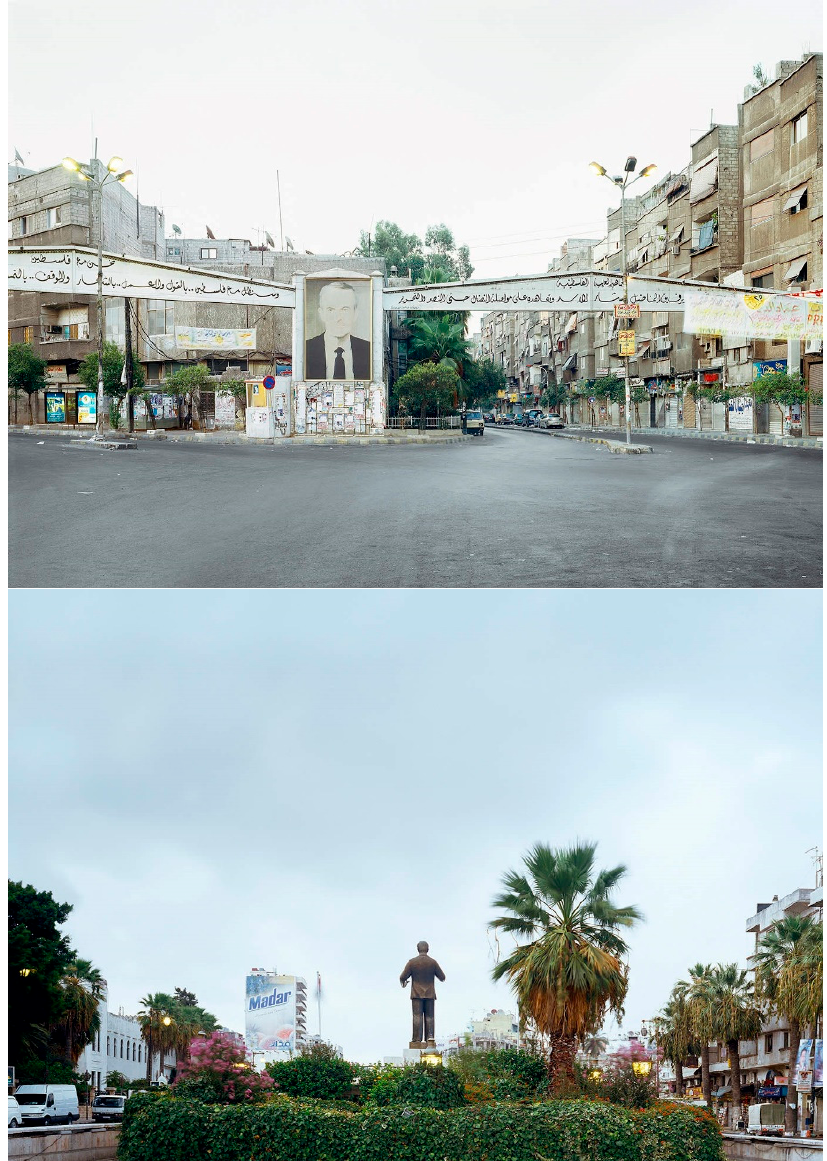
Figure 7. From Hrair’s ‘Execution Squares’ (2008). (Archival inkjet print). Used by permission of the artist.